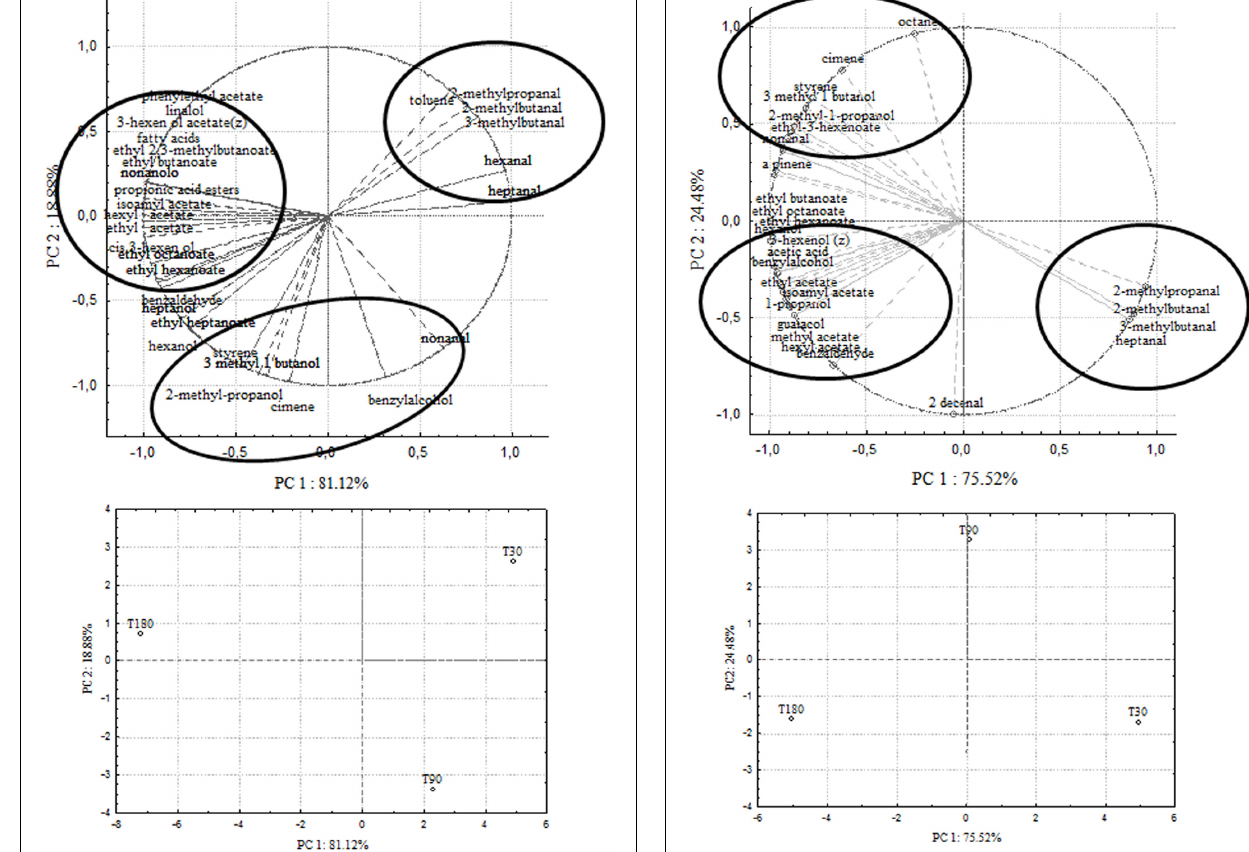
FIGURE 5 | PCA of volatile compounds associated with Cellina di Nardò fermented table olives. PCA variables were the data obtained from the analysis of concentration and presence of volatile compounds at three different fermentation times. The figure displays the sample scores and variable loadings in the planes formed by PC1–PC2.